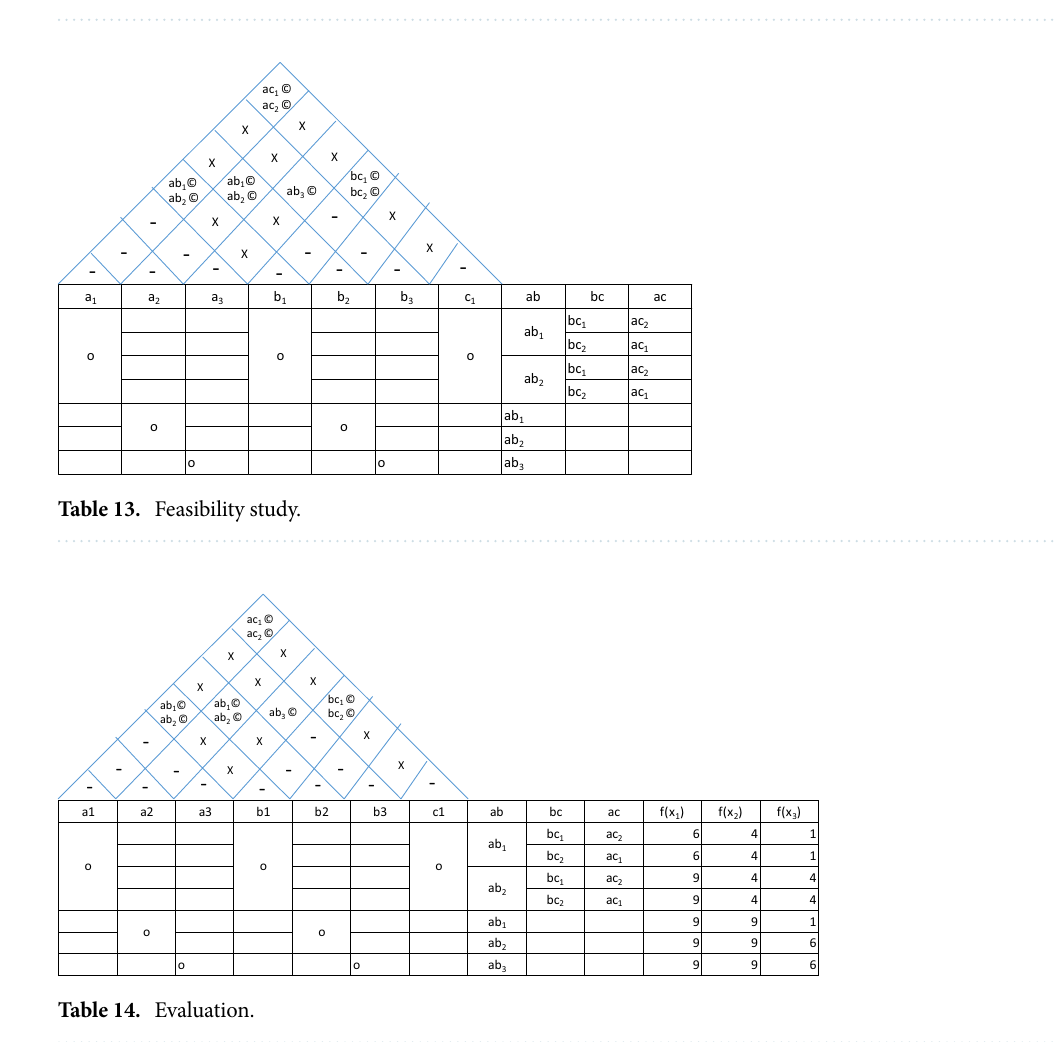
Table 12. Plotting the interfaces in the house of architecture.